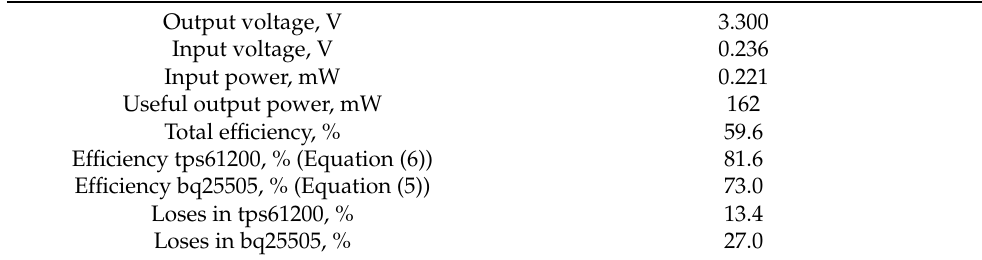
Table 5. Efficiencies and losses in the PMS.